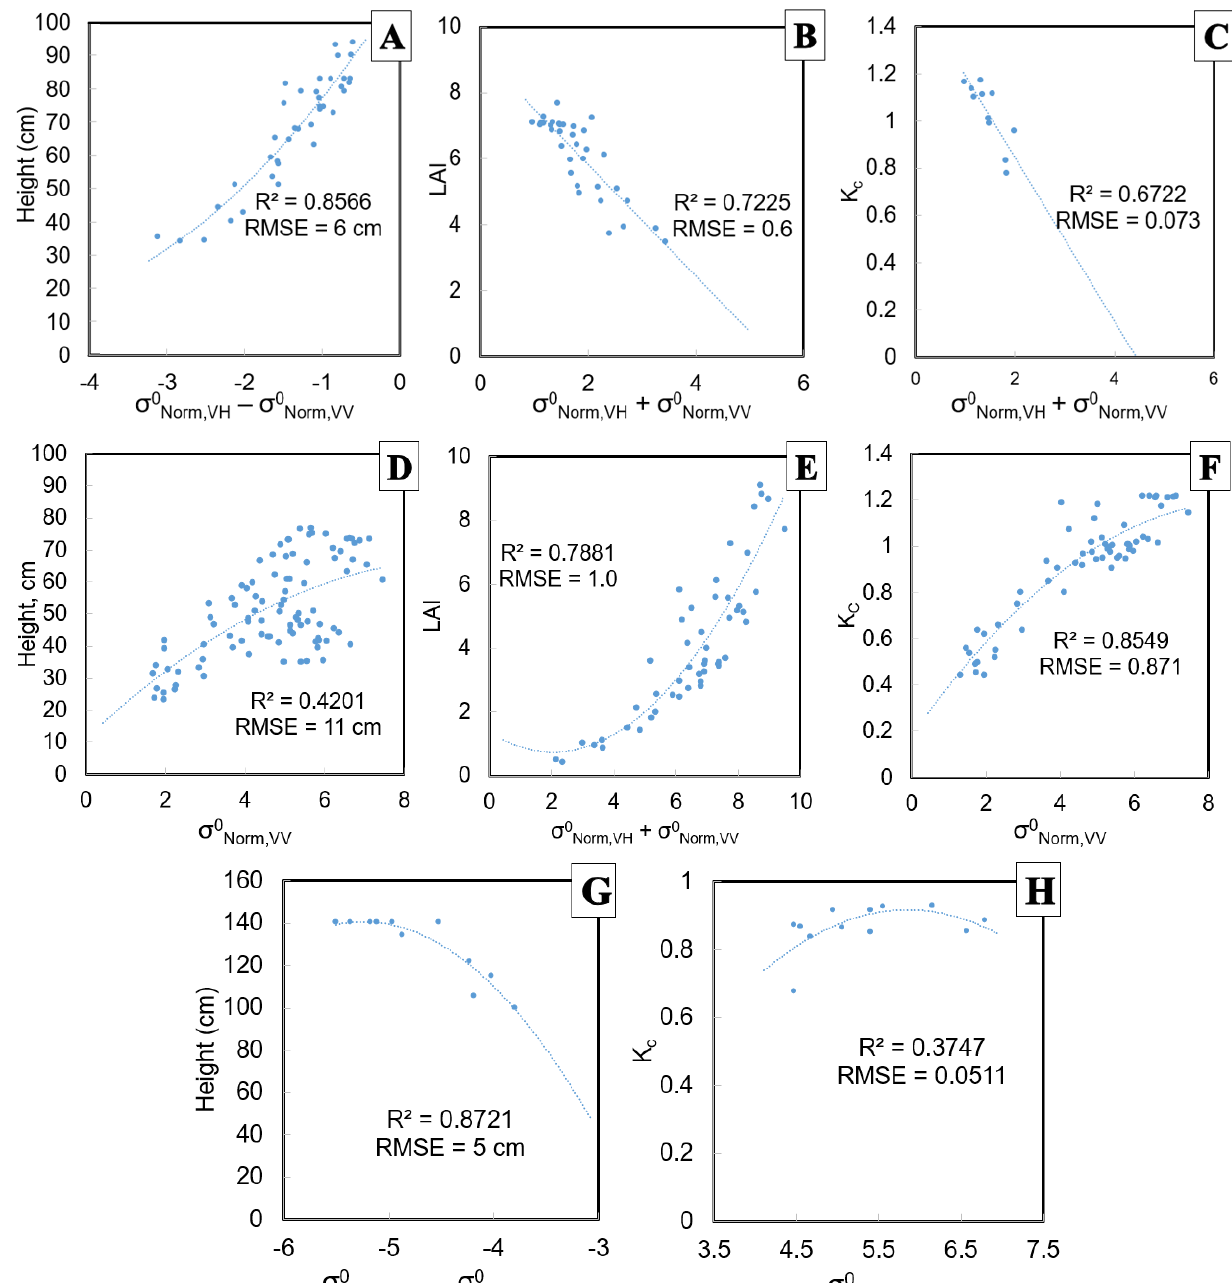
Figure 6. A time series of VV polarization values recorded by Sentinel-1 on its ascending overpasses with local incidence angles of 36.5° and 47.7° during the wheat experiment in Saad: ( A ) prior to applying the σ 0 normalization; ( B ) post-nor- malization.